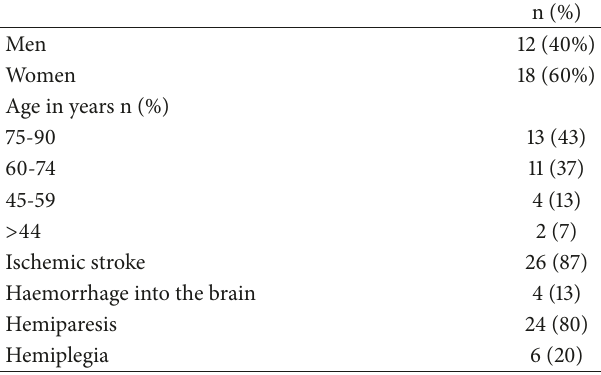
Table 1: Demographics and characteristics of study